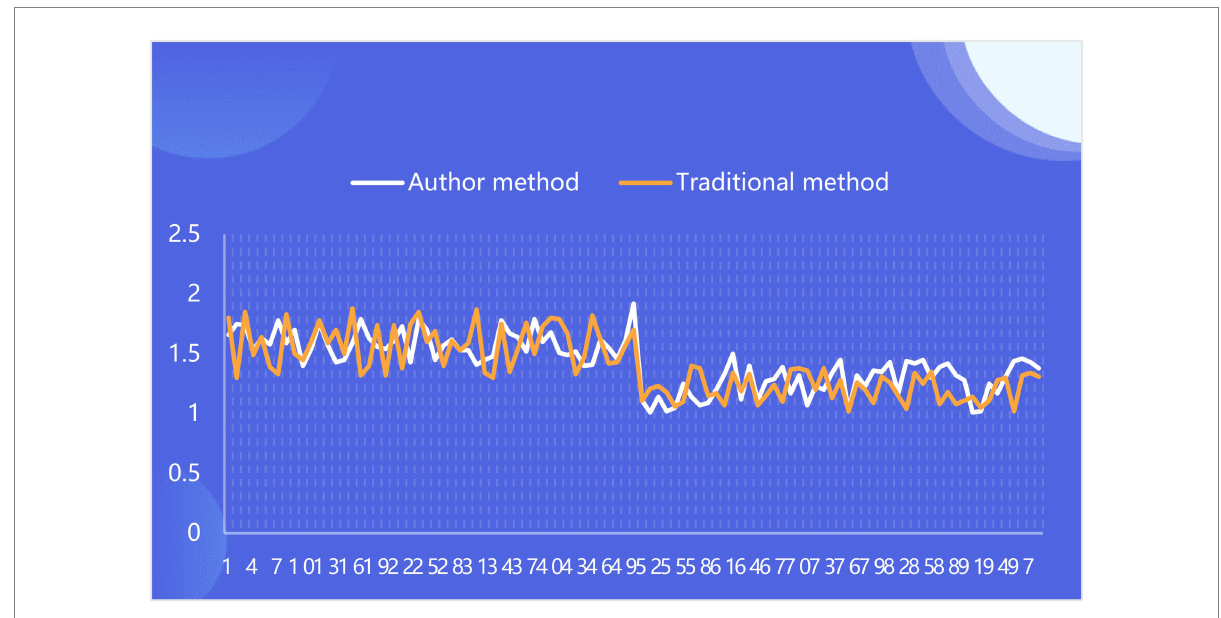
FIGURE 8 Experimental results of loss rate of model classification under different routing